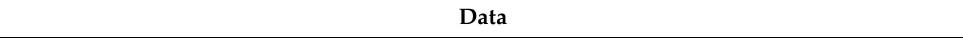
Table 11. Profile of transitional space of a Polish senior. Source: own elaboration on the basis of [90–101].